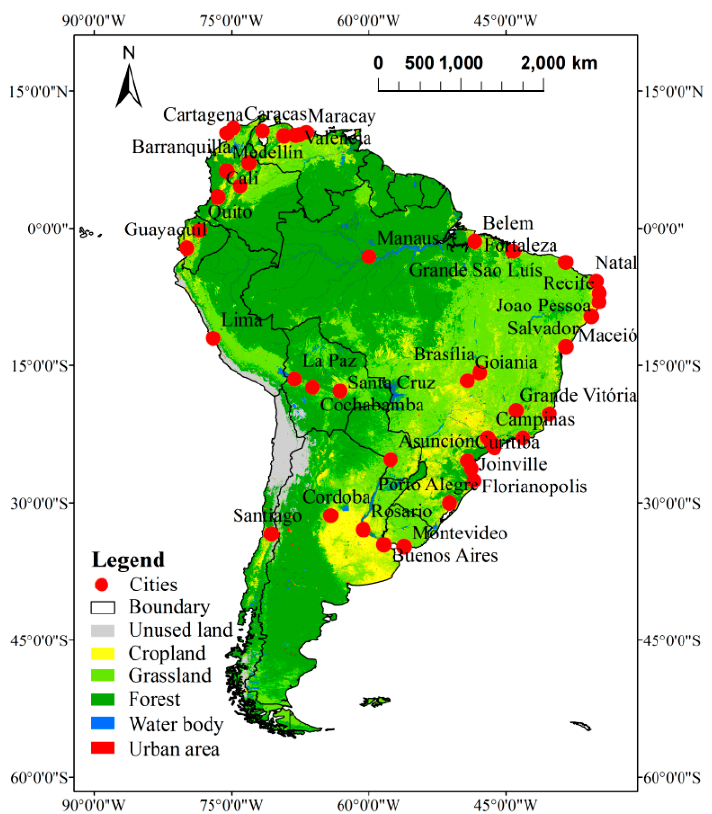
Figure 1. The spatial distribution of the 44 South American cities.